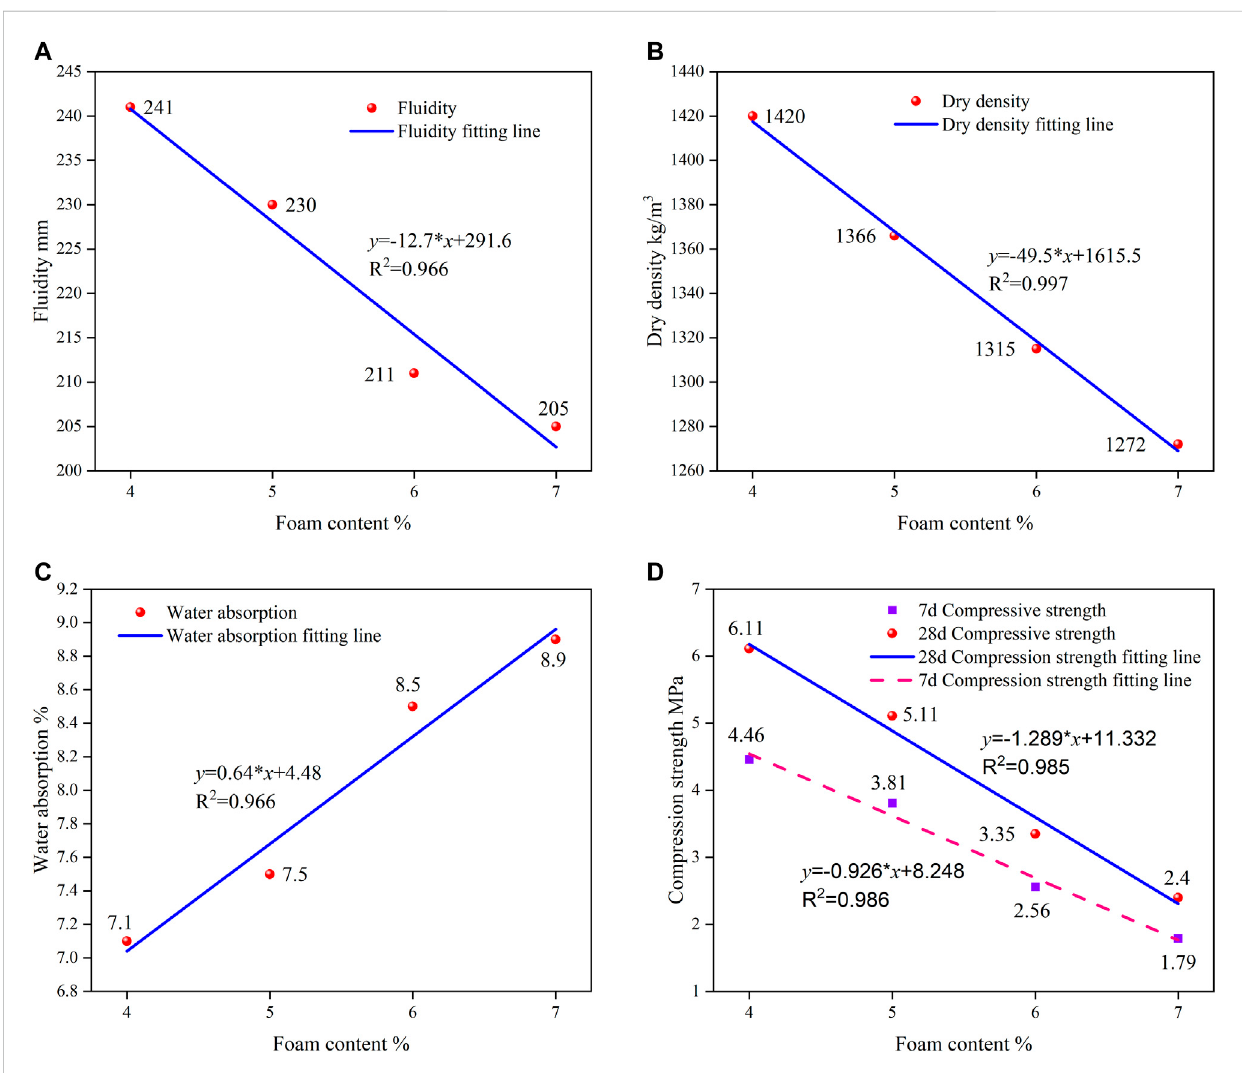
FIGURE 8 The in fl uence of foam content on sample performances: (A) fl uidity; (B) dry density; (C) water absorption; (D) compressive